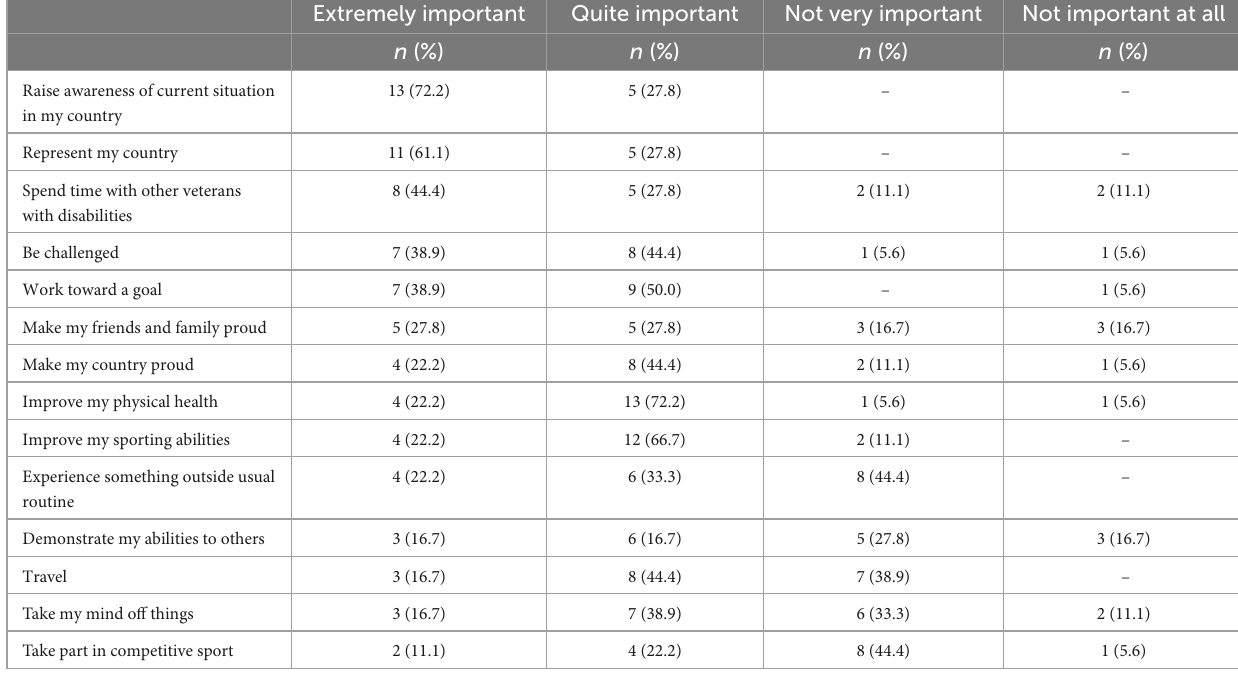
TABLE 7 Motivation for participating in the Warrior games (Survey 1 only). Extremely important Quite important Not very